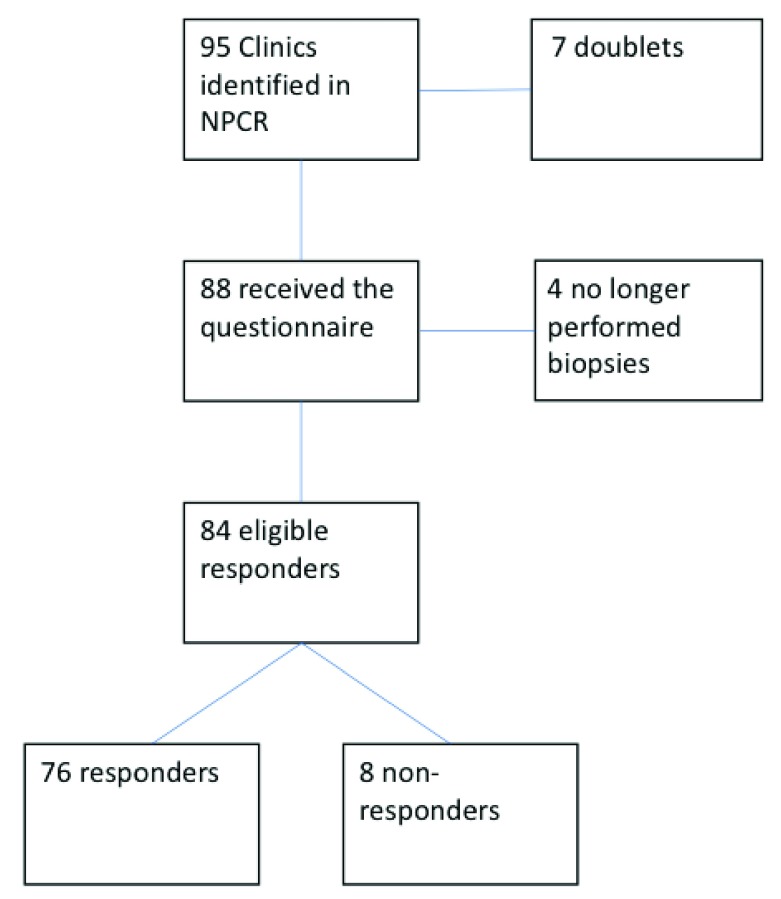
Flow chart of the selection of clinics.NPCR, The Swedish National Prostate Cancer Register.